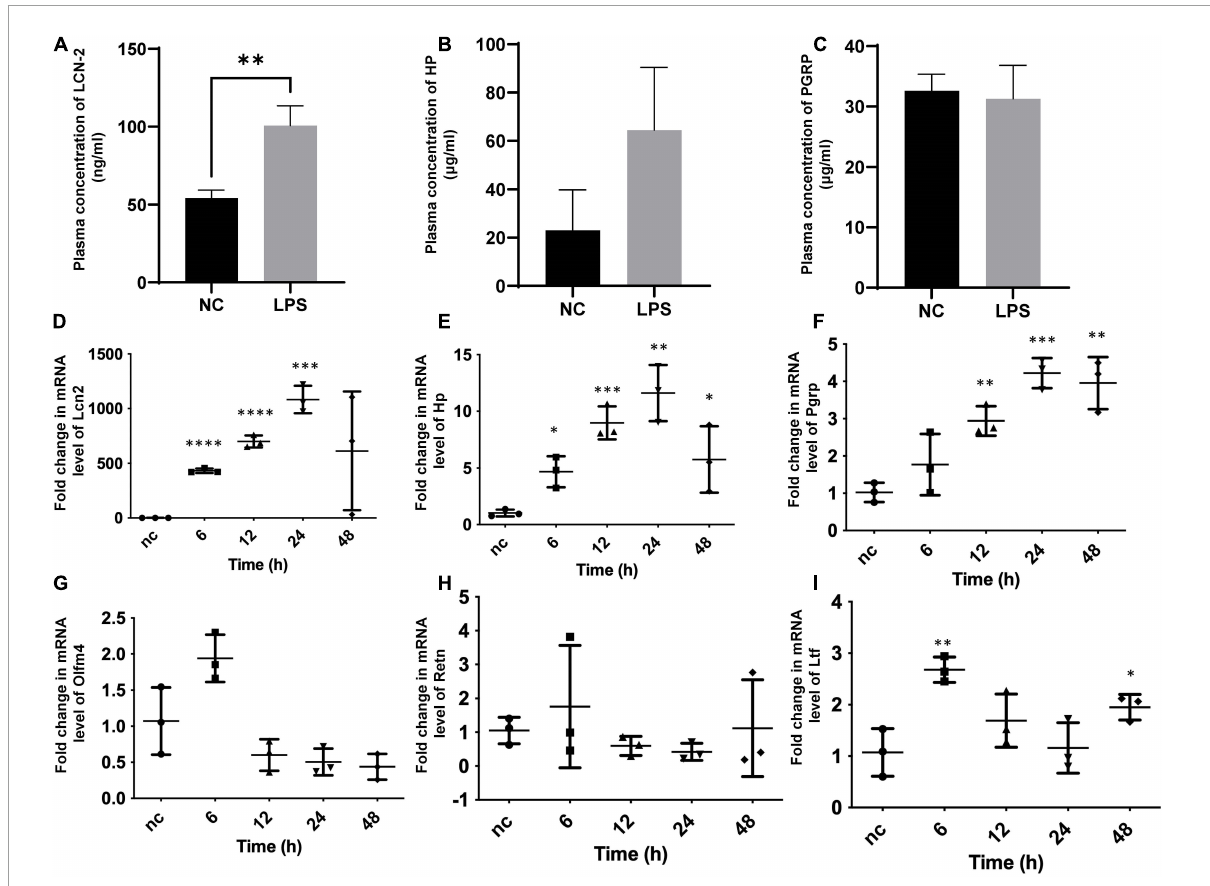
FIGURE3 Plasma assay for circulating concentration and qPCR of myocardial tissue for cardiac mRNA determination in SIC mouse. (A–C) Plasma concentration of LCN-2, HP, PGRP of both groups at 12 h after the induction of LPS. (D–I) Fold change in mRNA level of Lcn2, Hp, Pgrp, Olfm4, Retn, Ltf of myocardial tissue at different times testing by qPCR. Hp, haptoglobin; Lcn2, lipocalin-2; Ltf, lactotransferrin; Olfm4, olfactomedin-4; Pgrp, peptidoglycan recognition protein-1; Retn, resistin. * P < 0.05, ** P < 0.01, *** P < 0.001, and **** P <